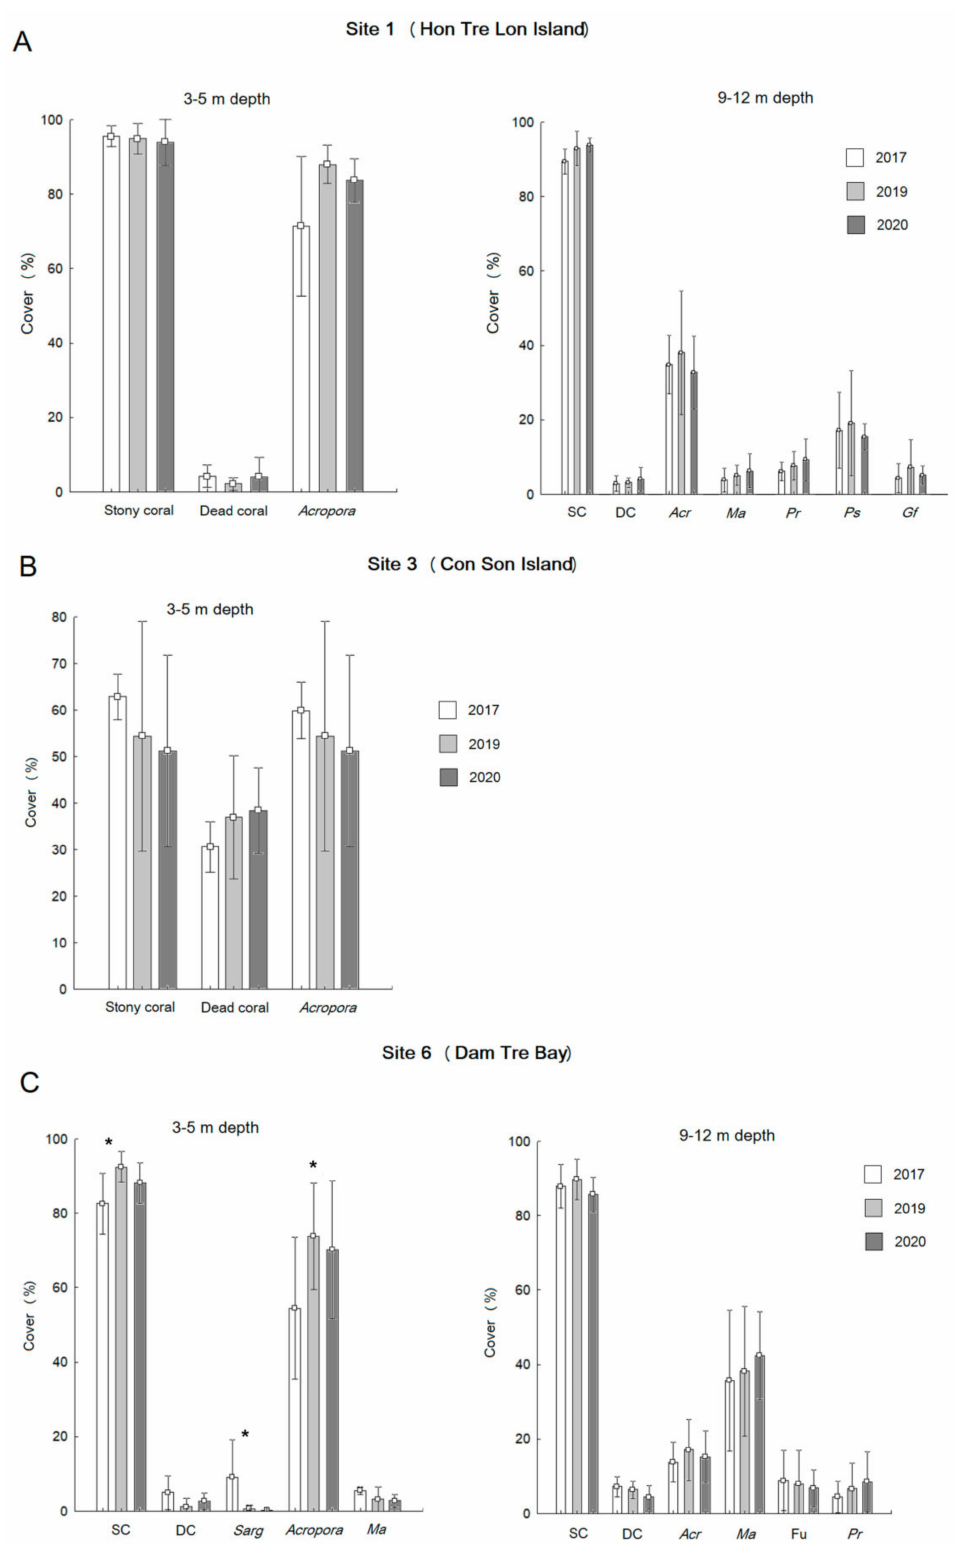
Figure 6. Temporal variations over the 3-year period in covers ( ± SD) of stony coral, dead coral and dominant coral taxa (by cover > 5% in at least one of 3 years of observations) at three target sites (( A – C ), sites 1, 3 and 6). SC: stony coral; DC: dead coral; Acr: Acropora spp.; Sarg: Sargassum sp.; Ma: Montipora aequituberculata ; Pr: Porites rus ; Ps: Pachyseris speciosa ; Gf: Galaxea fascicularis ; Fu: Fungiidae. Significant differences (ANOVA, p < 0.05) are marked by